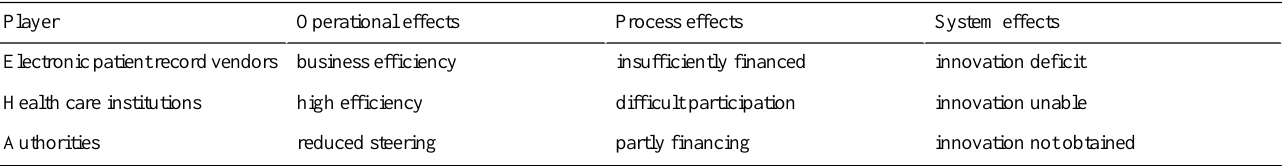
Table 2. Effect of neo-liberalistic policy concerning innovation of electronic cooperation tools in Norwegian health